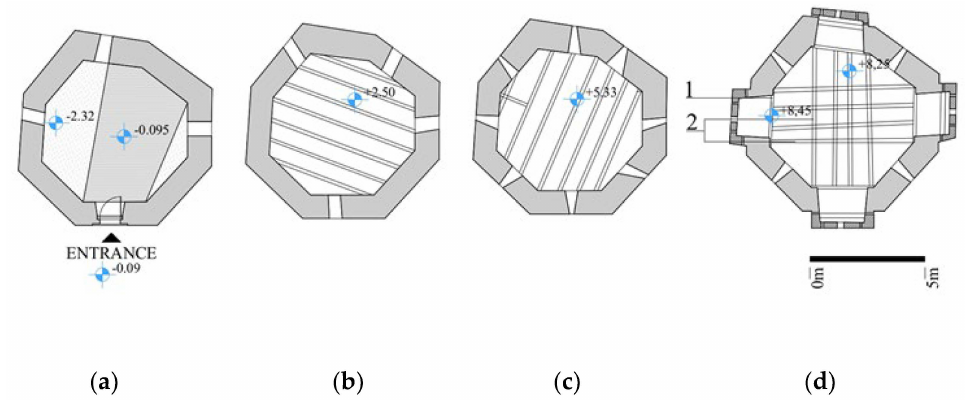
Figure 21. Base of the Tower Motrilja. ( a ) Ground floor. ( b) First floor. ( c ) Second floor. ( d ) Attic: 1—wooden beam; 2—slat; (Drawigns: Lejla Ze´cirovi´c).